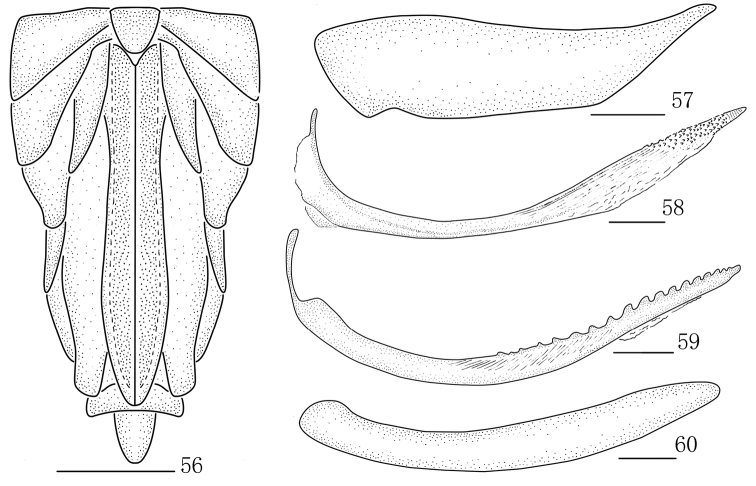
Parasogatafurcasp. n., female 56 Abdomen, ventral view 57 Gonocoxa VIII 58 Gonapophysis VIII 59 Gonapophysis IX 60 Gonoplac. Scale bars: 0.5 mm (56); 0.2 mm (57–60).